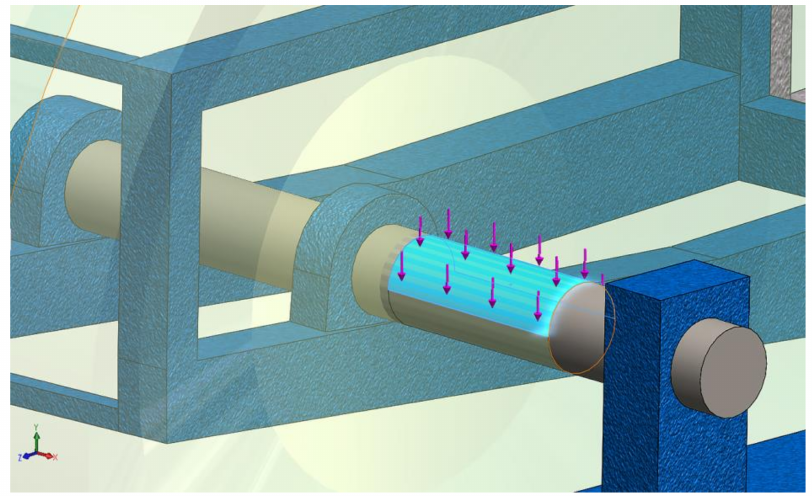
Figure 7. Imposing the total resultant force to the model.